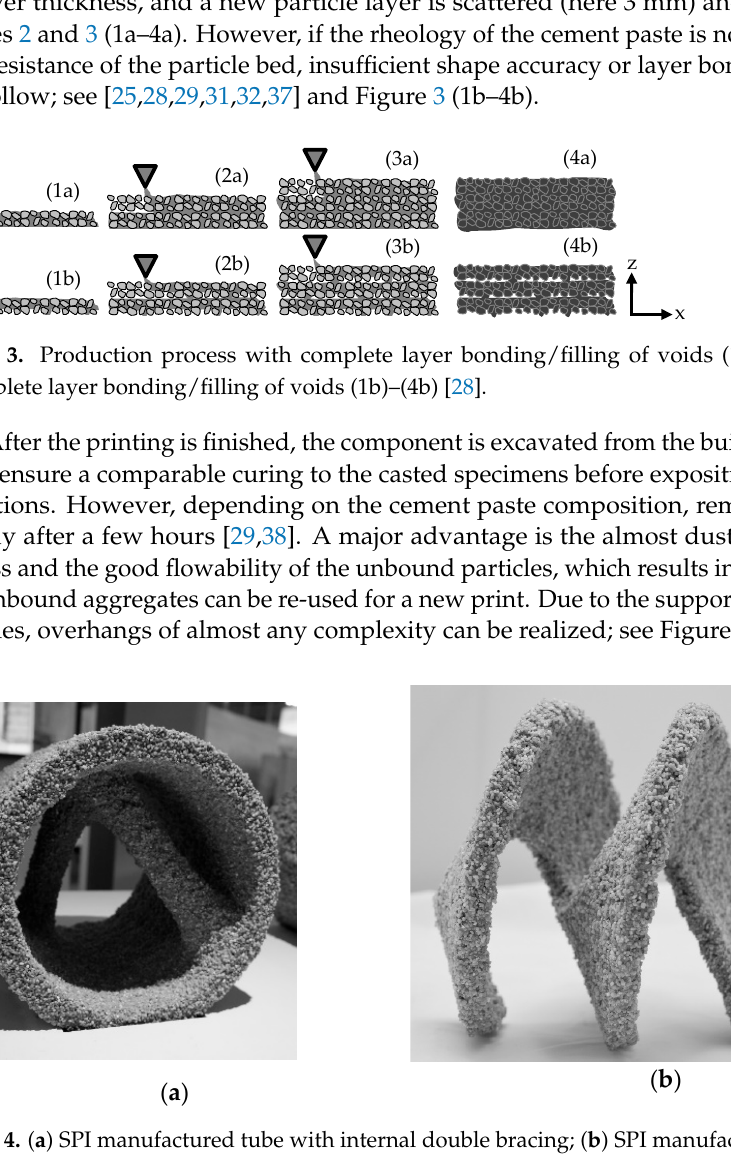
Figure 2. Selective paste intrusion (SPI) printer used for the investigations [36].